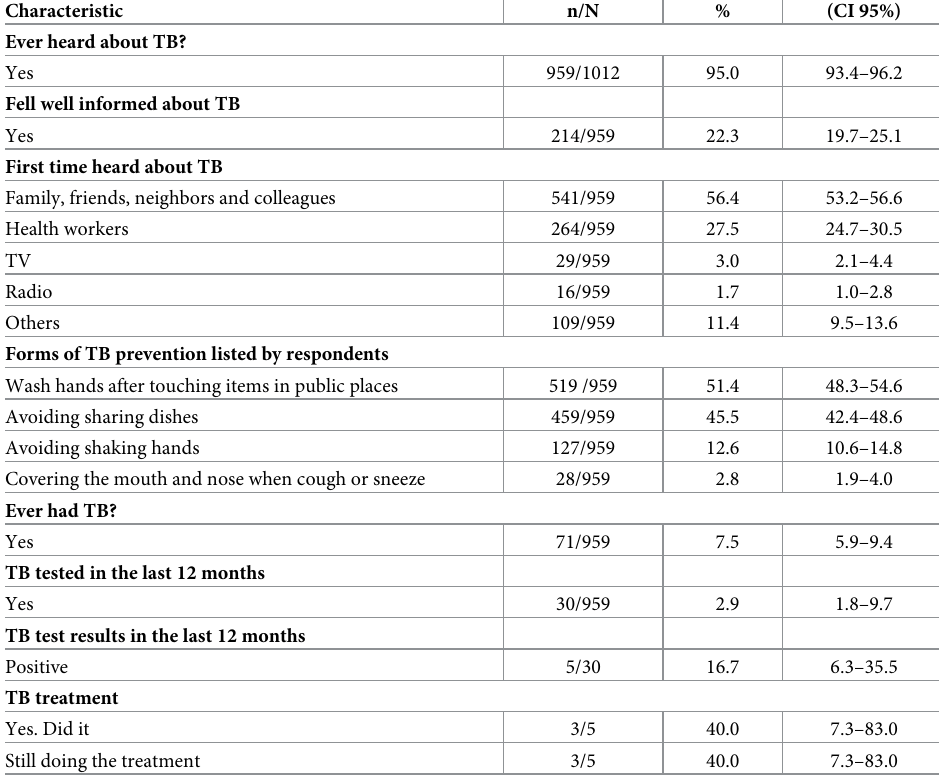
Table 5. TB history and knowledge in miners community of origin, Gaza Province, Southern of Mozambique, 2017.